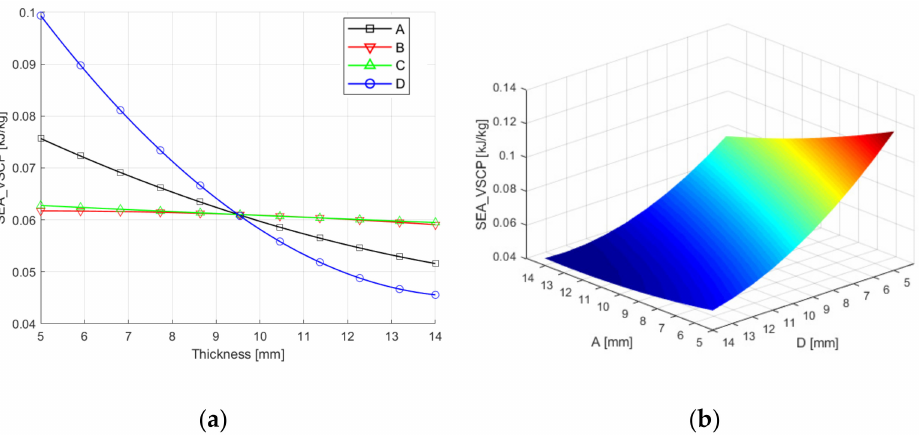
Figure 16. Effect of thickness on the SEA_VSCP response: ( a ) effect of single variable thickness on SEA_VSCP; ( b ) response surface of SEA_VSCP with Parameters A and